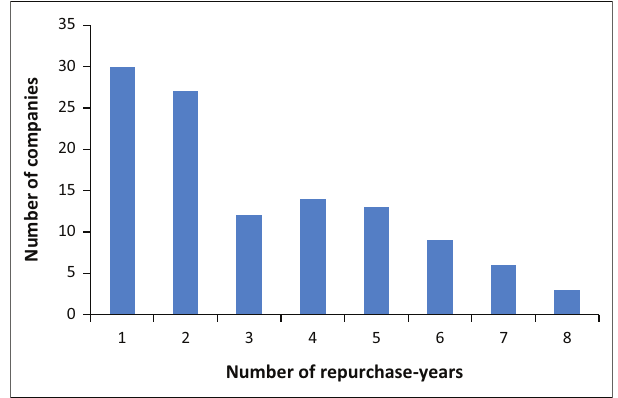
FIGURE 1: Frequency distribution of repurchase-years of the companies participating in repurchases.